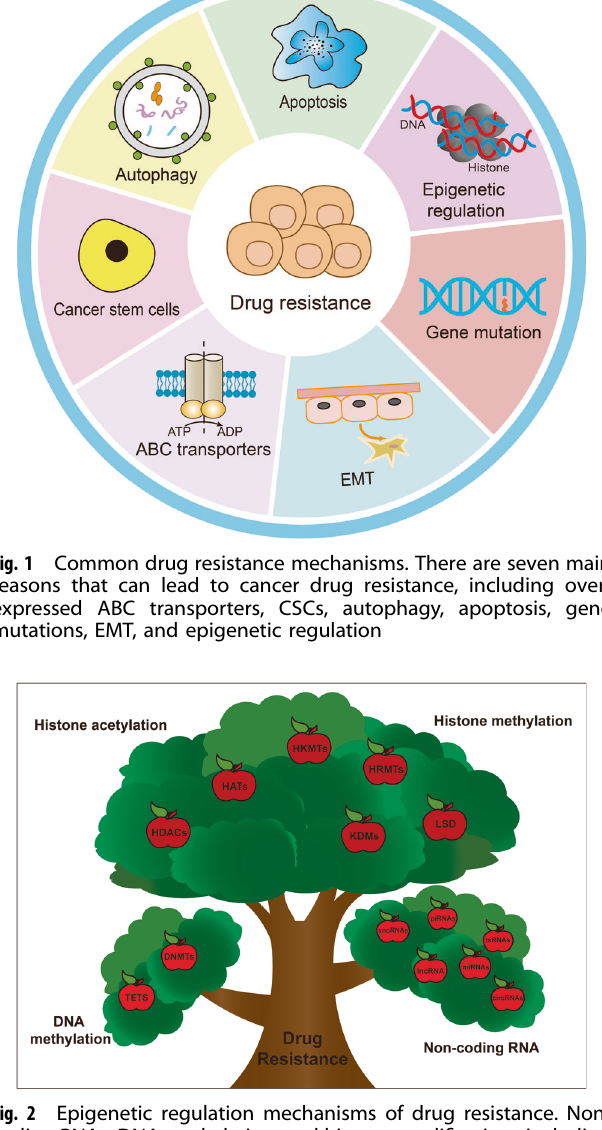
resistance. Herein, in this review, we fi rst summarize the roles of different epigenetic regulators in tumor resistance. We further summarize the classi fi cation and functions of histone demethy- lases and describe the relationship between histone demethylases and cancer drug resistance in detail.